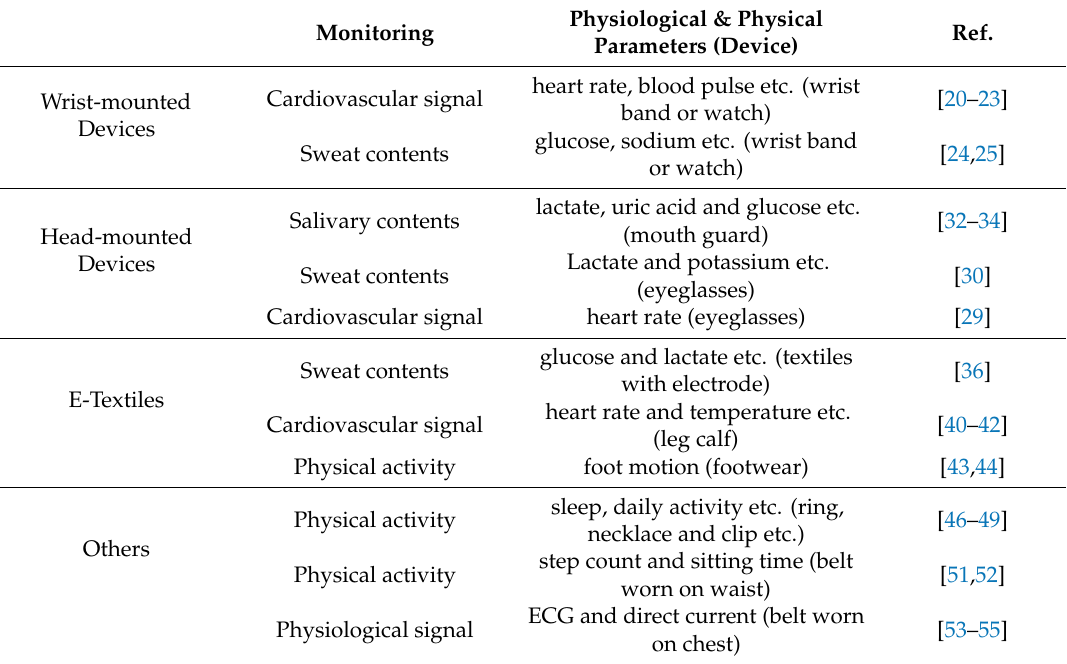
Table 1. Summary of portable